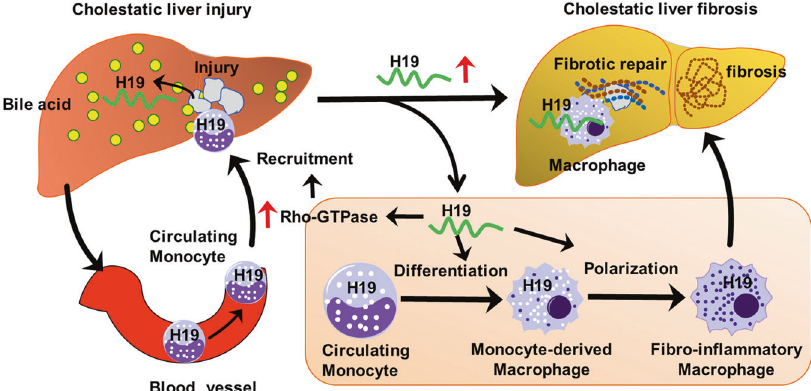
Fig. 9 Schematic diagram of mechanisms for macrophage functions in the cholestatic liver fi brosis. The accumulated bile acids caused liver injuries in cholestatic livers, which attracted the monocytes/macrophages from the peripheral circulation to repair damages. Once monocytes/macrophages cells reached the injured areas, H19 increased their activation and polarization and subsequently promoted the liver fi brosis progression. H19 can induce macrophage migration into the injured liver. H19 also promotes macrophage differentiation and polarization in the cholestatic